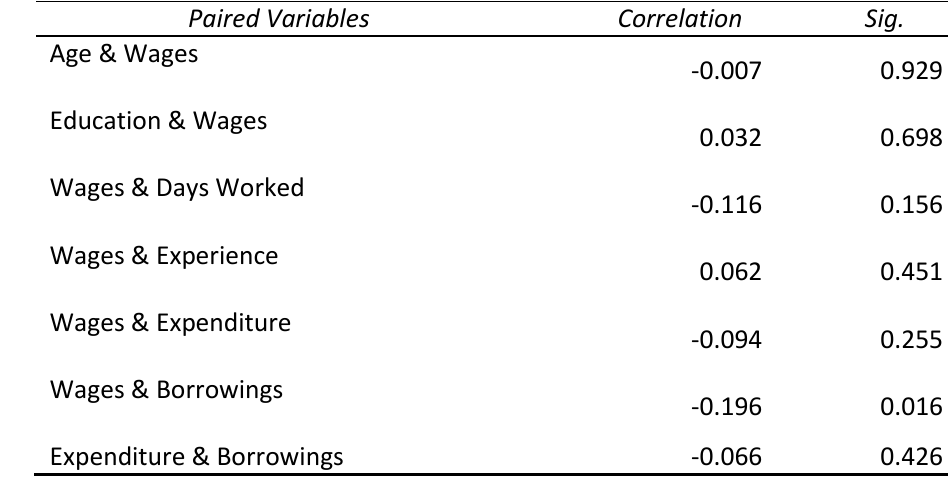
Table 3: Correlation Co-efficient for the Dependent Variable Paired Variables